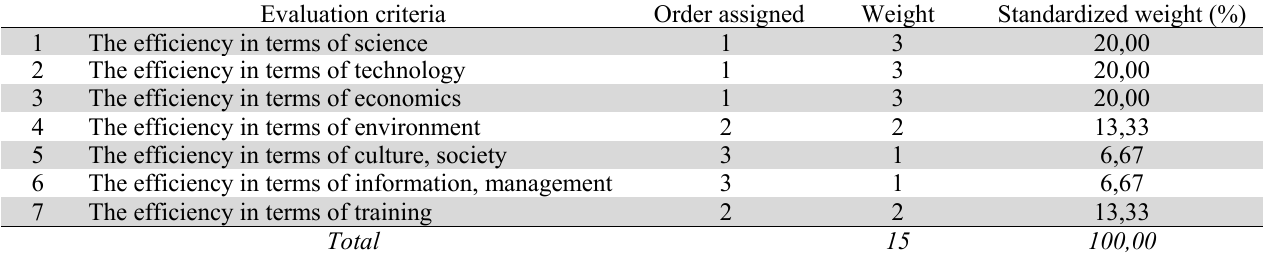
Illustrating the weights of the evaluation criteria in the Agricultural field